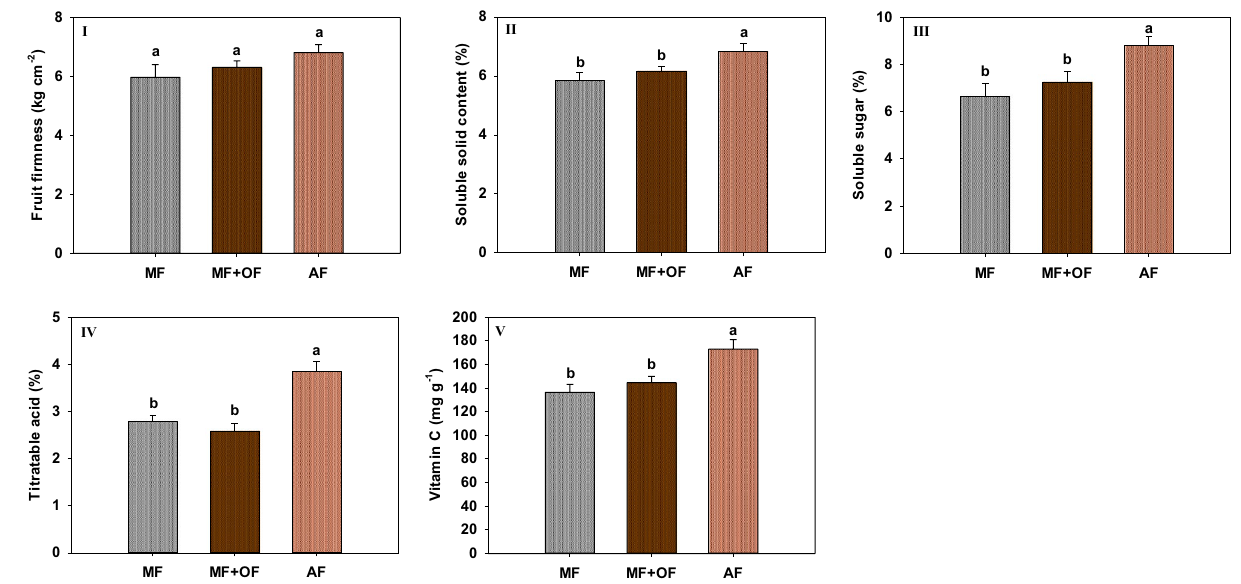
Figure 1. The fruit firmness (kg cm -2 ) ( I ), the soluble solid content (%) ( II ), the soluble sugar content (%) ( III ), the titratable acid content (%) ( IV ), and Vitamin C content (mg per 100 g) ( V ) of kiwifruits under the treatments of AF (Fenton reaction produced fertilizer at 2.0 kg per each plant, equivalent to 0.4 kg N, 0.2 kg P2O5 and 0.24 kg K2O per plant), OF + MF (organic fertilizer plus mineral fertilizers with 32 kg fermented pig manure, 0.52 kg urea, 0.18 kg superphosphate, and 0.22 kg potassium sulfate per plant), and MF (mineral fertilizers of 0.87 kg urea, 1.25 kg superphosphate, and 0.48 kg potassium sulfate). The different letters in each sub-figure indicated the significant differences of the variable between the samples under different treatments. The vertical bars represent the standard errors for the variable values.